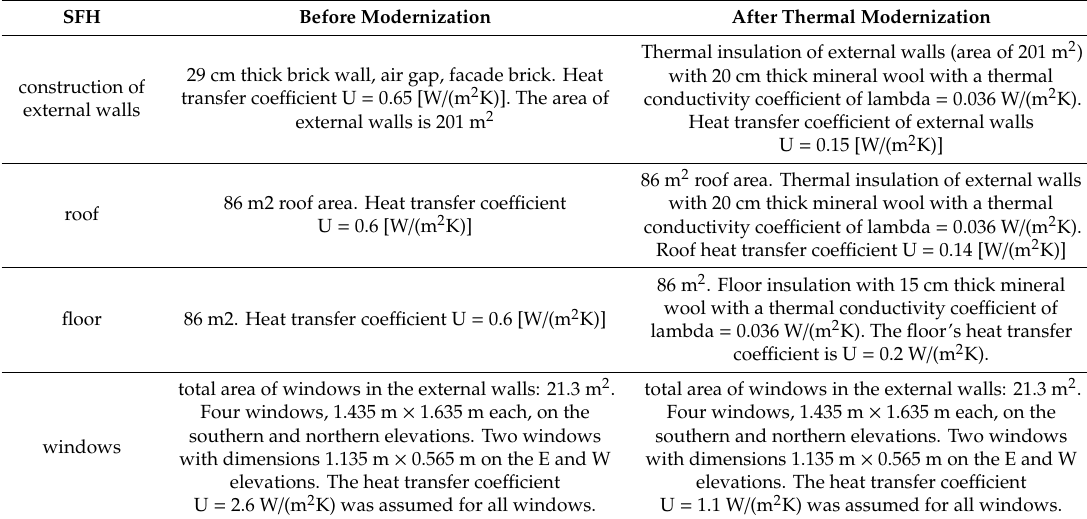
Table 1. Model single-family houses (SFH) configuration